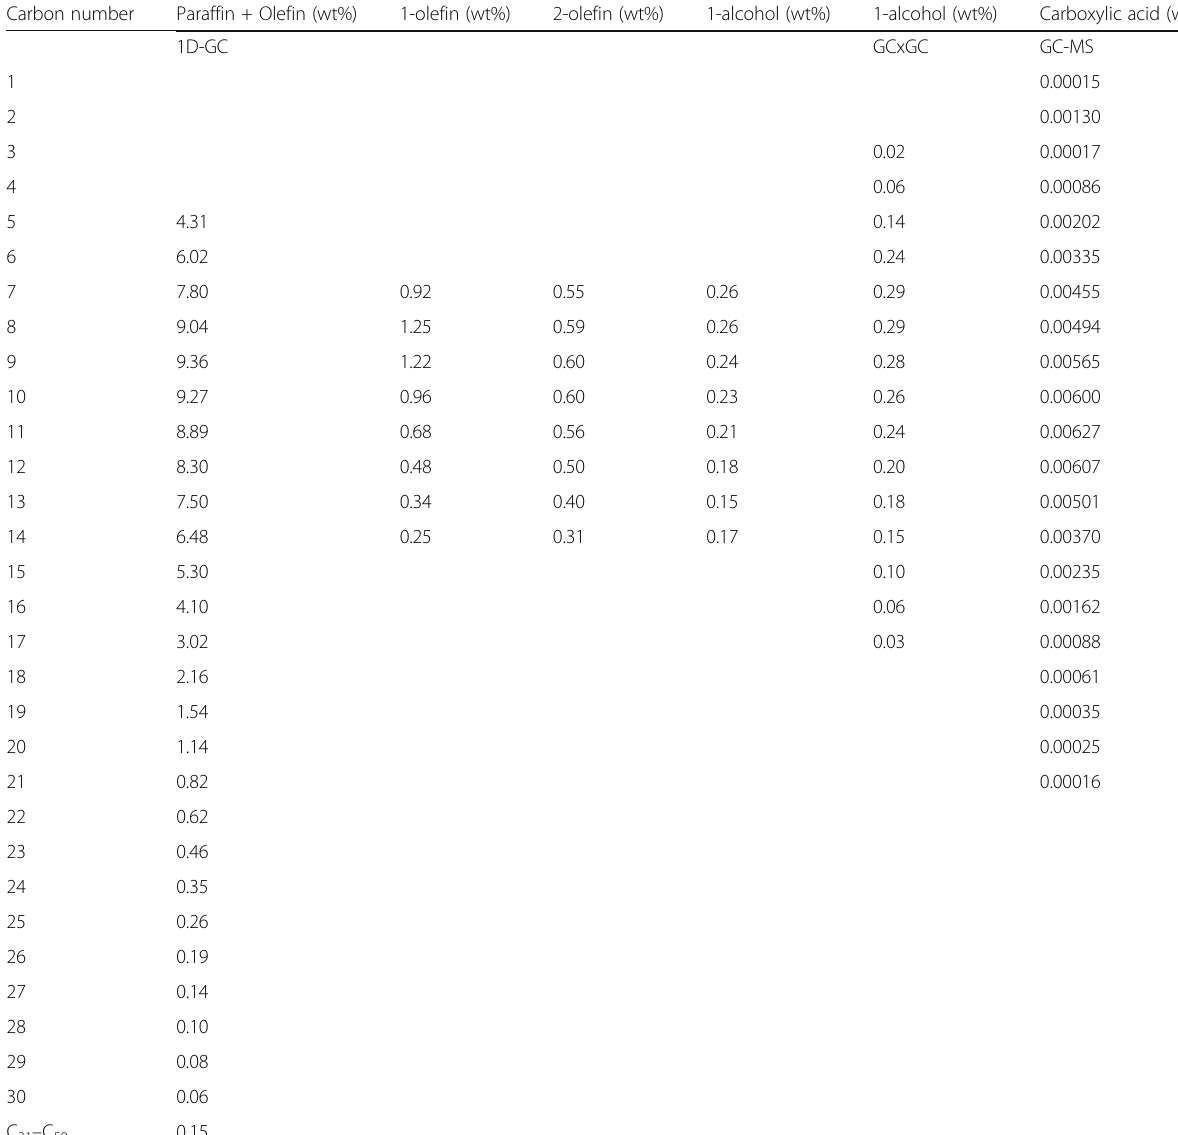
Table 4 Summary of 1D-GC, GCxGC and GC-MS analyses, LHcL1 Carbon